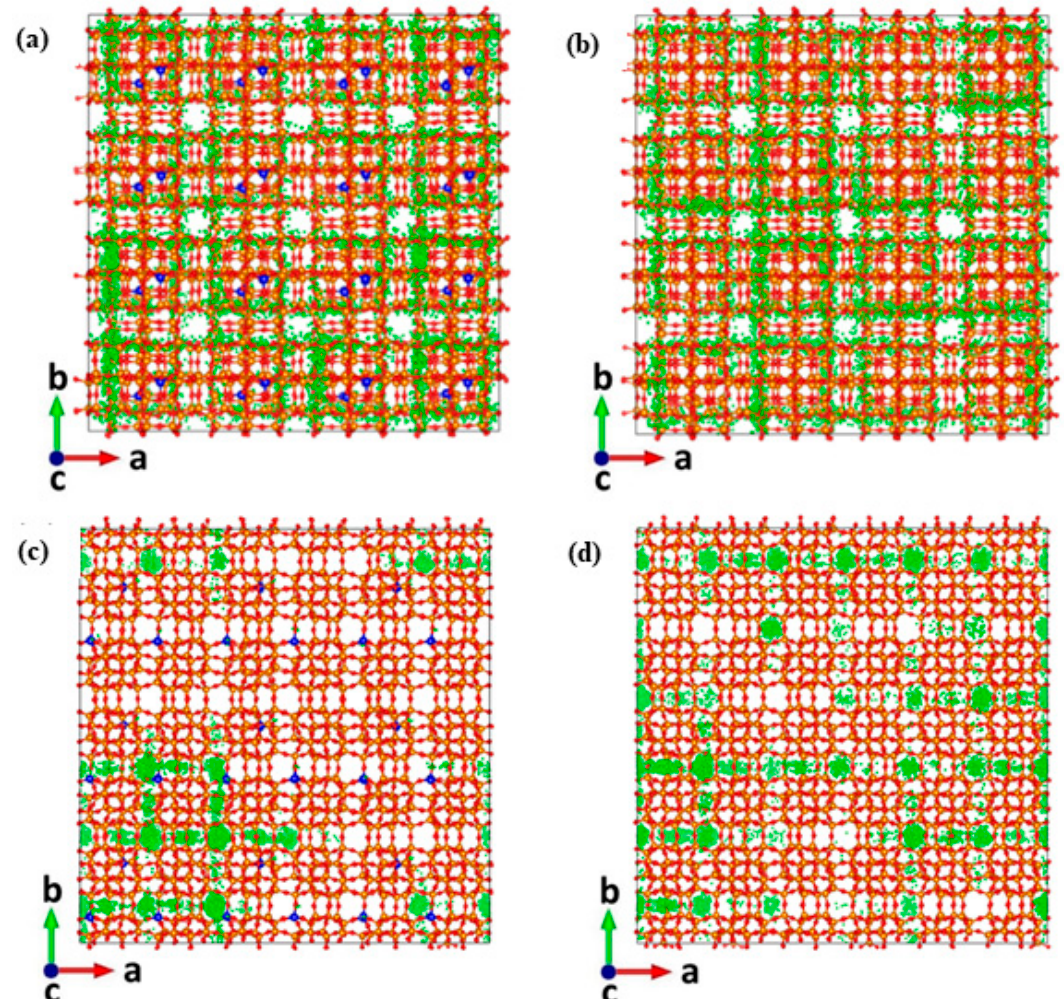
Figure 2. Trajectory of a single methanol molecule at 473 K in ( a ) H-Beta ( b ) all-silica Beta c direction at a loading of 4 mpuc, and in ( c ) H-MFI and ( d ) all-silica MFI c direction at a loading of 5 mpuc. Element color code: O (red), Si (orange), Al (blue), center of mass for CH 3 OH (green).